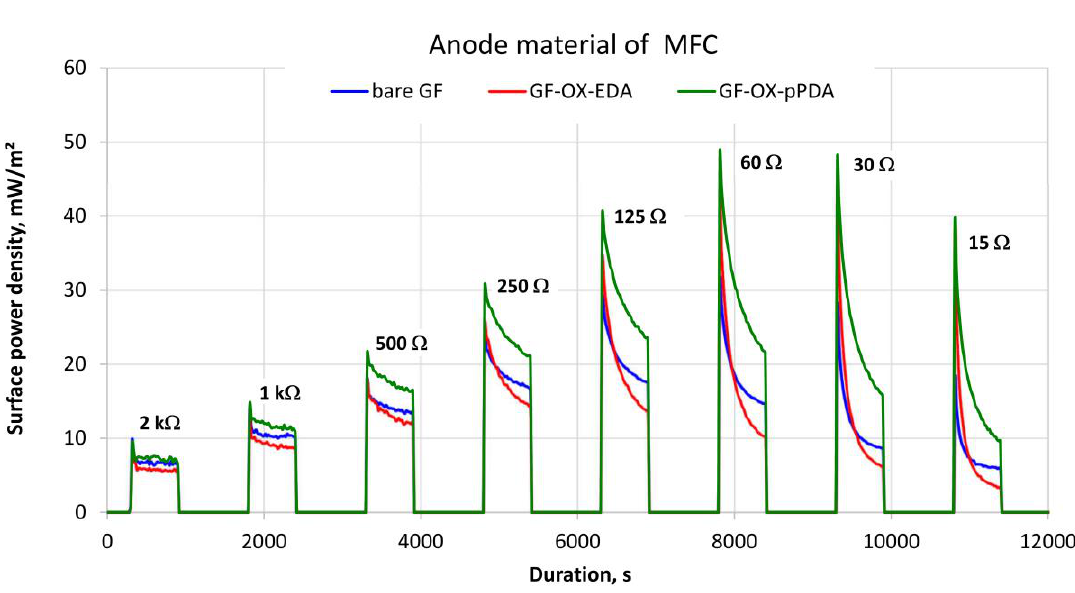
Figure 8. Dependence of MFCs’ surface power density (over a 10 min periods) on applied electric load.